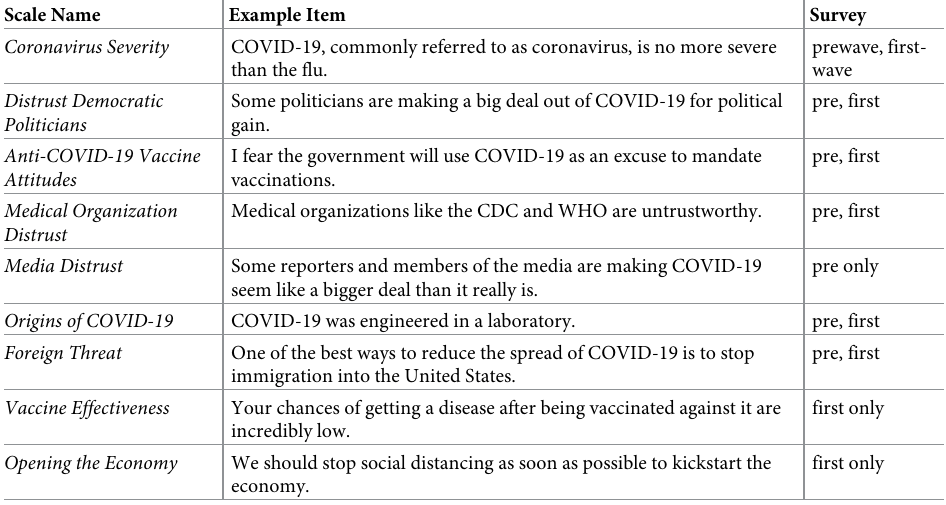
Table 1. Examples of questions on nine scales designed to assess attitudes related to